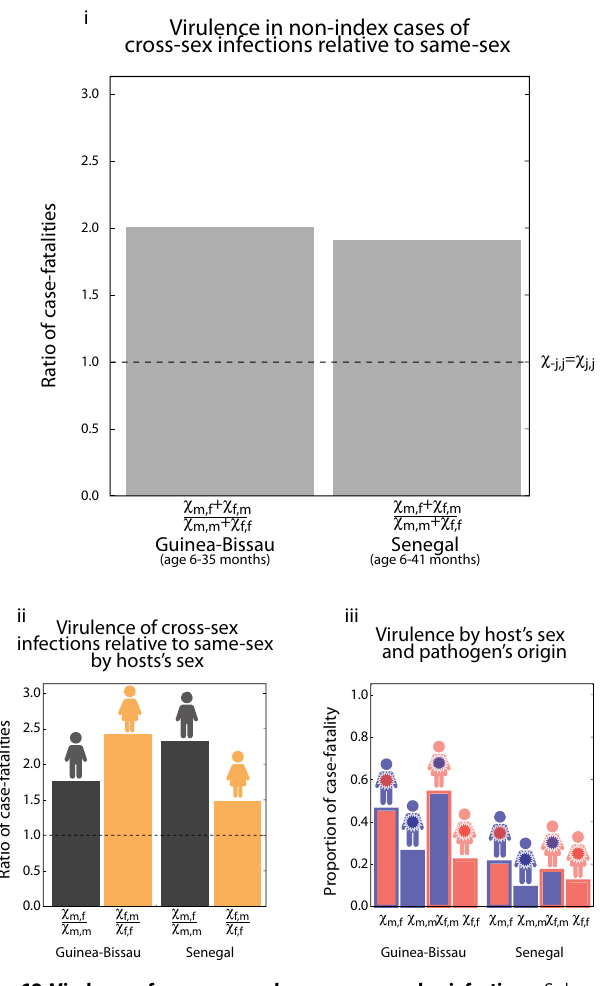
Fig. 10 Virulence of cross-sex and same-sex measles infections. Sub- panel i shows the ratio of case fatalities ( χ ) in cross-sex infections relative to same-sex infections, de fi ned as ( χ mf + χ fm )/( χ mm + χ ff ), in two studies conducted in children 6-35 months old in Guinea-Bissau and Senegal. Notice that in both cases infections from the opposite sex are roughly twice as virulent as infections from the same sex. Sub-panel ii shows the ratio of case fatalities in cross-sex infections relative to same-sex infections broken down by sex of the infected. This ratio in infected boys is given by the proportion of boys infected by girls relative to the one infected by boys, that is χ mf / χ mm and in infected girls is given by the proportion of girls infected by boys relative to the one infected by girls, that is χ fm / χ ff . Notice that in all cases infections from the opposite-sex are more virulent than infections from the same-sex, that is χ ¬ jj / χ jj > 1, ranging between 1.5 and 2.5 times more virulent. Finally, sub-panel iii shows the proportion of case fatalities in each of the sexes when infected by each of the other sexes in the two studies conducted in Guinea-Bissau and Senegal 23,24